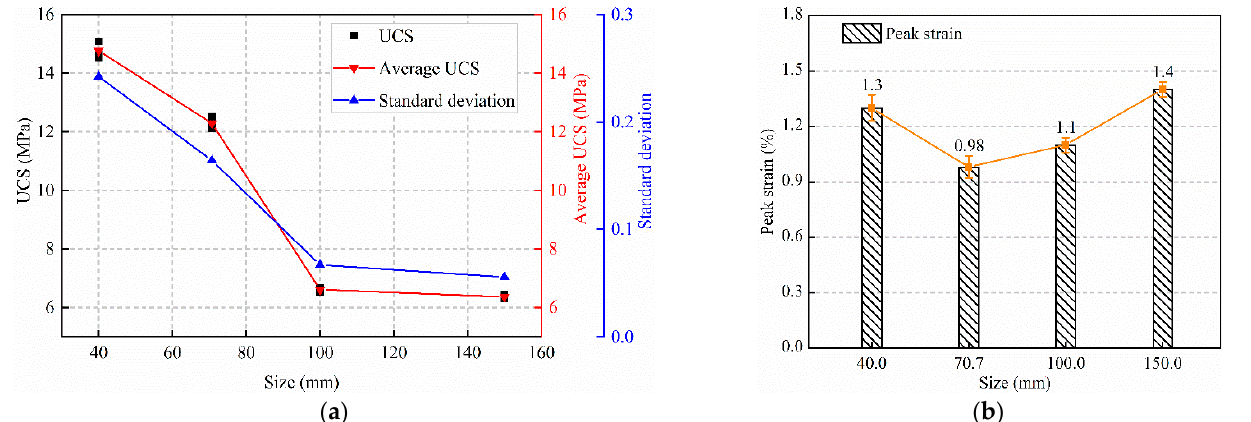
Figure 4. The results of uniaxial compression test; ( a ) UCS curve ( b ) peak strain.